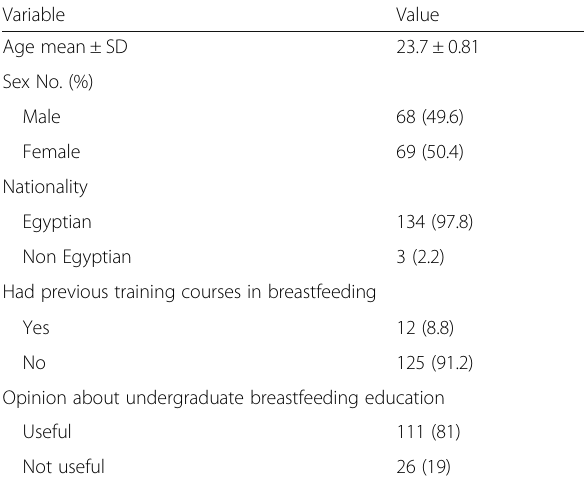
Table 1 Background characteristics of the participating interns ( n = 137) at Cairo University Hospital, Egypt, 2017 – 2018